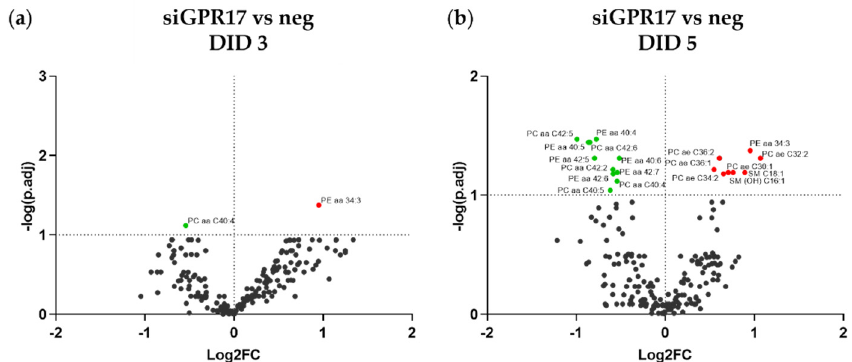
Figure 8. Lipidomic changes induced by GPR17 silencing in OPCs. ( a , b ) The abundance of each lipid after GPR17 silencing has been normalized to that in the relative control sample. The resulting fold changes were used to generate a volcano plot for each time point (3, 5 days in differentiation). The points over the dotted horizontal line represent the metabolites that have shown a statistically significant change (Fisher’s LSD corrected by FDR; p.adj < 0.1). In green, lipids with lower expression, in red, those with higher expression, after GPR17 silencing. n = 5 per each group.